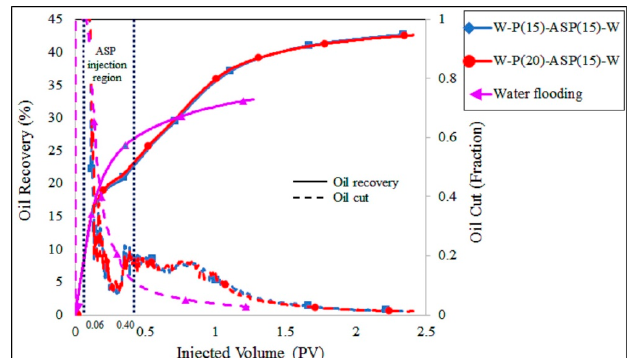
Figure 3. Oil production performance of water flooding and two flooding sequences of the (P) group in which the first injected polymer solutions have viscosity of 15 and 20 cp.